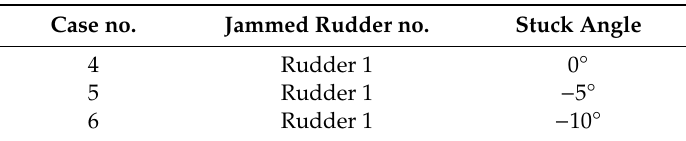
Table 3. Rudder jam